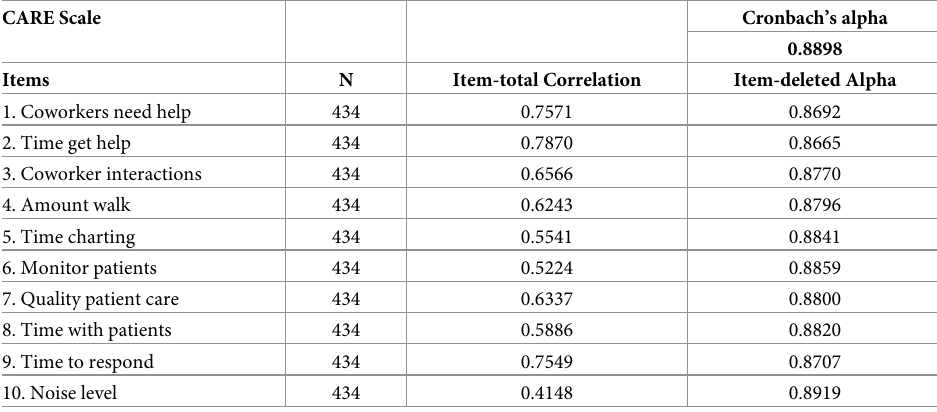
Table 5. Phase 1 Cronbach’s coefficient alpha and item-total correlations.